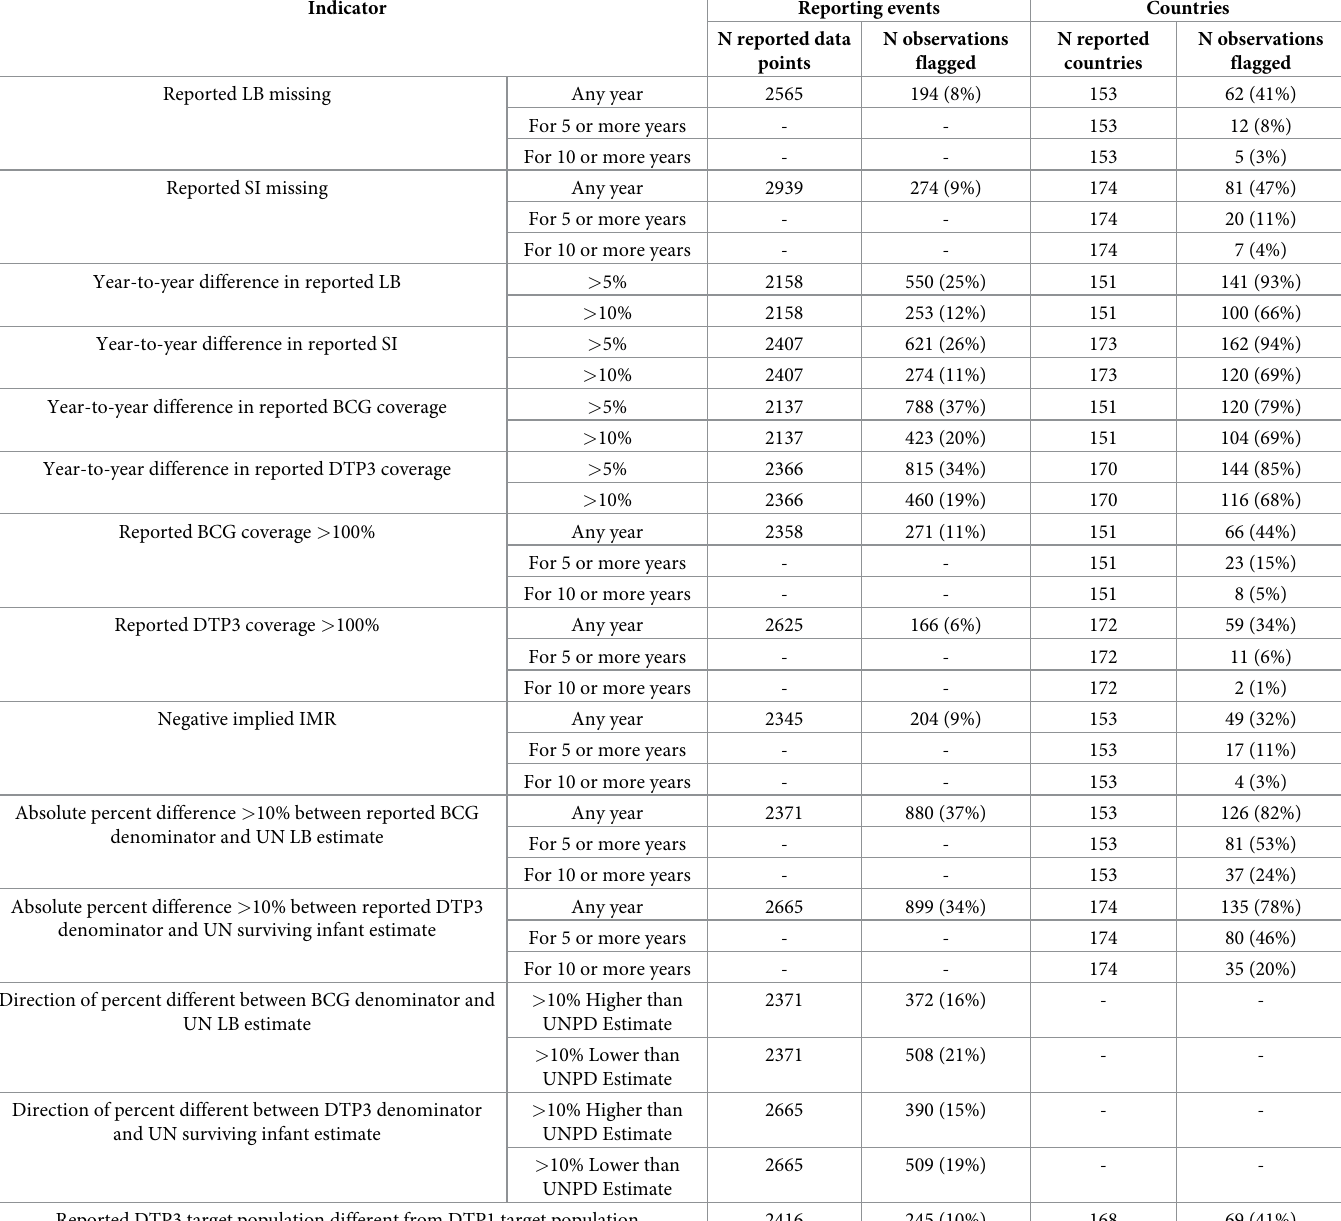
Table 1. Summary of denominator consistency and accuracy indicators flagged, WHO Member States, 2000–2016.